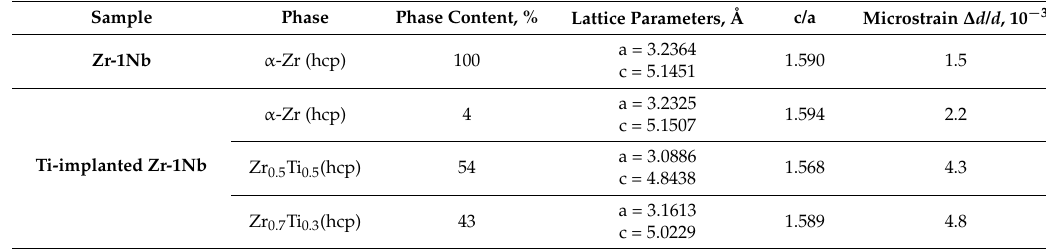
Table 1. The results of X-ray diffraction (XRD) analysis.